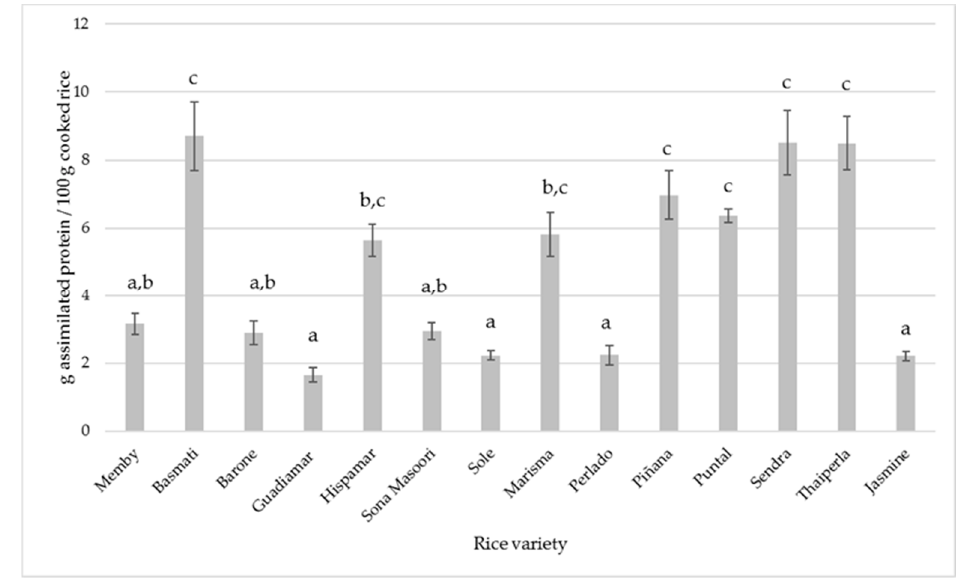
Figure 3. Estimation of assimilated protein in cooked rice consumed (g/100 g). Different letters in the same row indicate significant differences by ANOVA test ( p < 0.05).